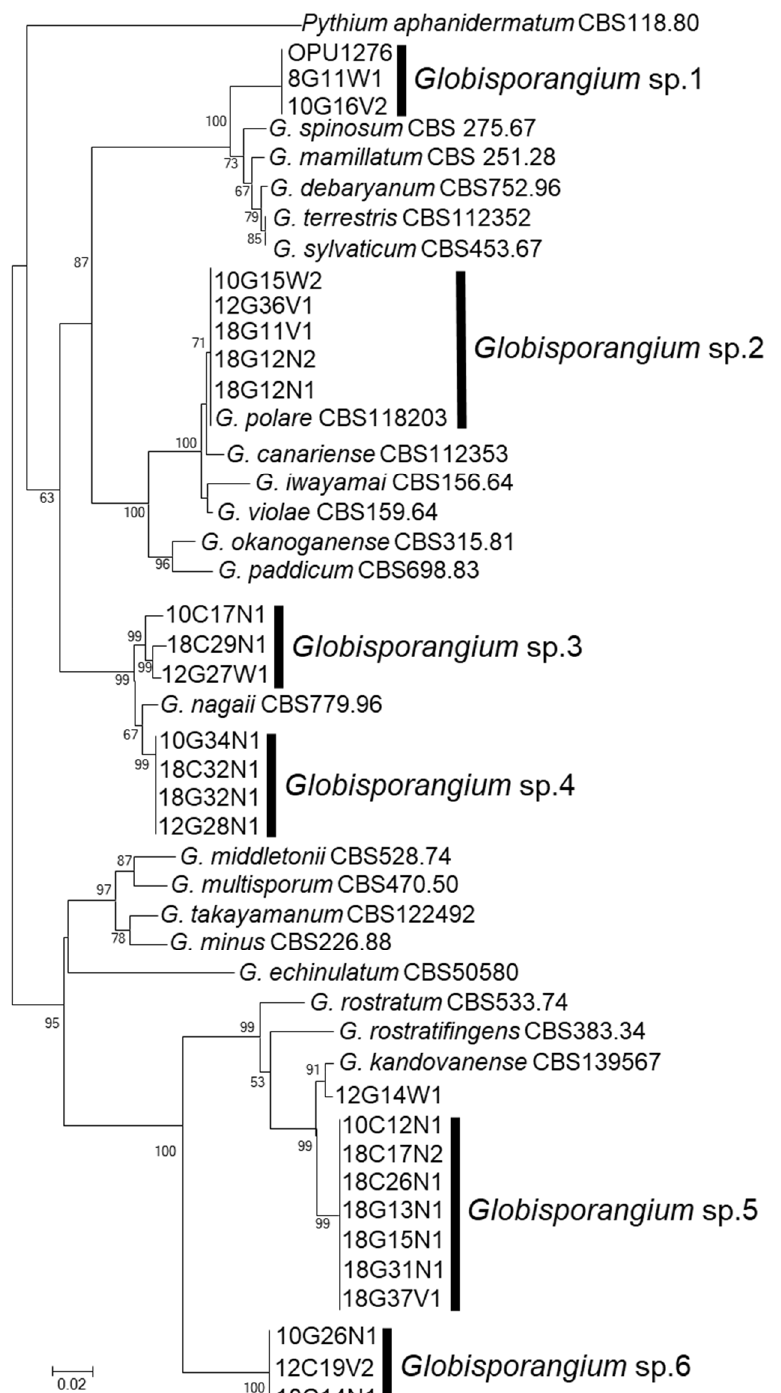
Figure 2. Phylogenetic positions of Globisporangium strains obtained from the Sanionia moss in Ny-Ålesund, Spitsbergen Island, Norway, on a neighbor-joining (NJ) tree of the ITS of the rDNA region. Numbers beside the branches are the bootstrap values (>50%) of 1000 replicates. Pythium aphanidermatum strain CBS118.80 was used as an outgroup. The six major subclades found in this study were named as Globisporangium spp. 1–6.